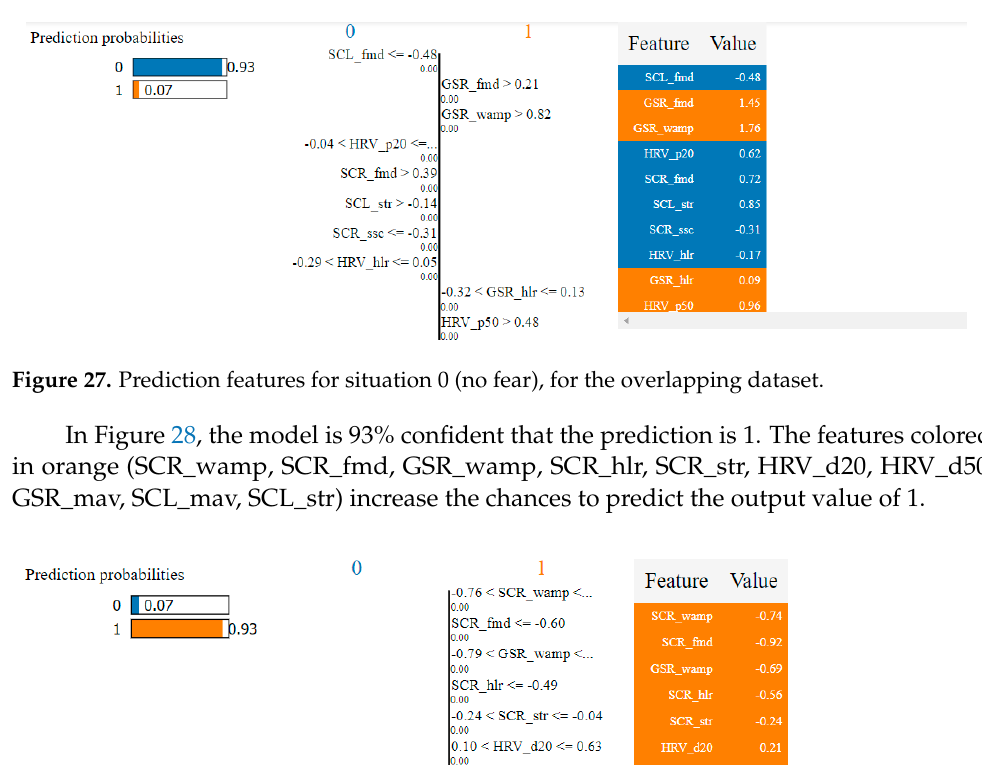
Figure 26. Prediction features for situation 1 (fear), for the non-overlapping dataset.